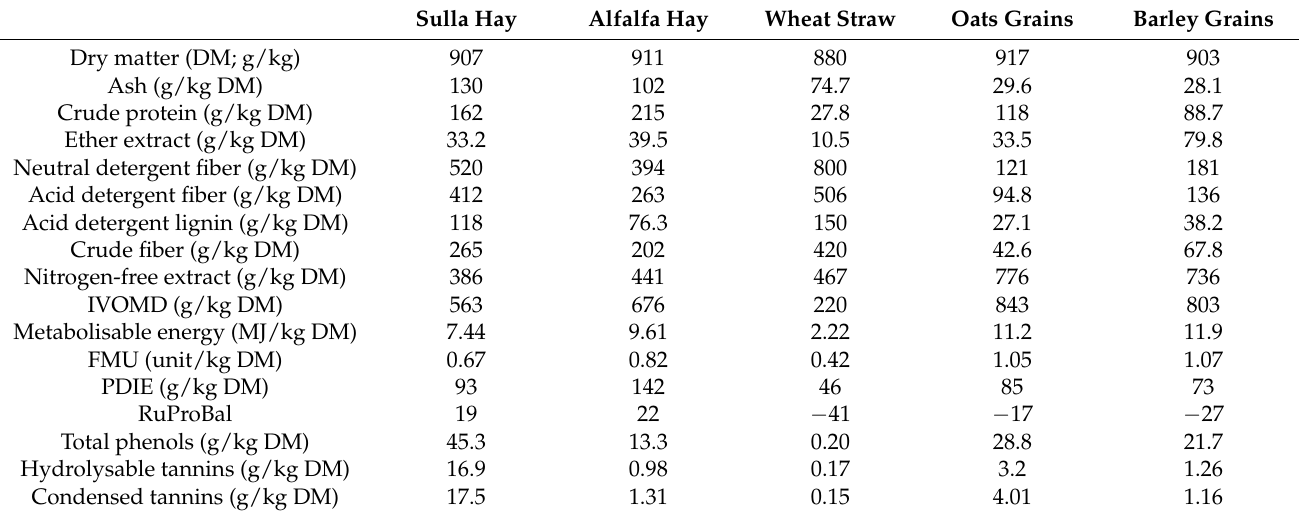
Table 2. Chemical composition of the diet ingredients. Sulla Hay Alfalfa Hay Wheat Straw Oats Grains Barley